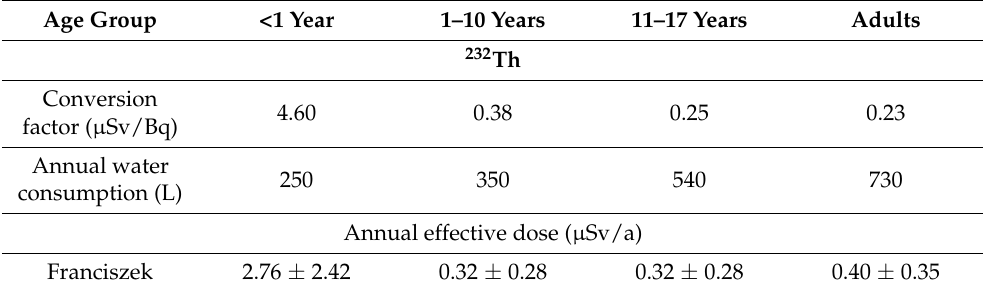
Table 4. Average annual effective doses of the uptake of 232 Th in drinking water in the Franciszek sample.